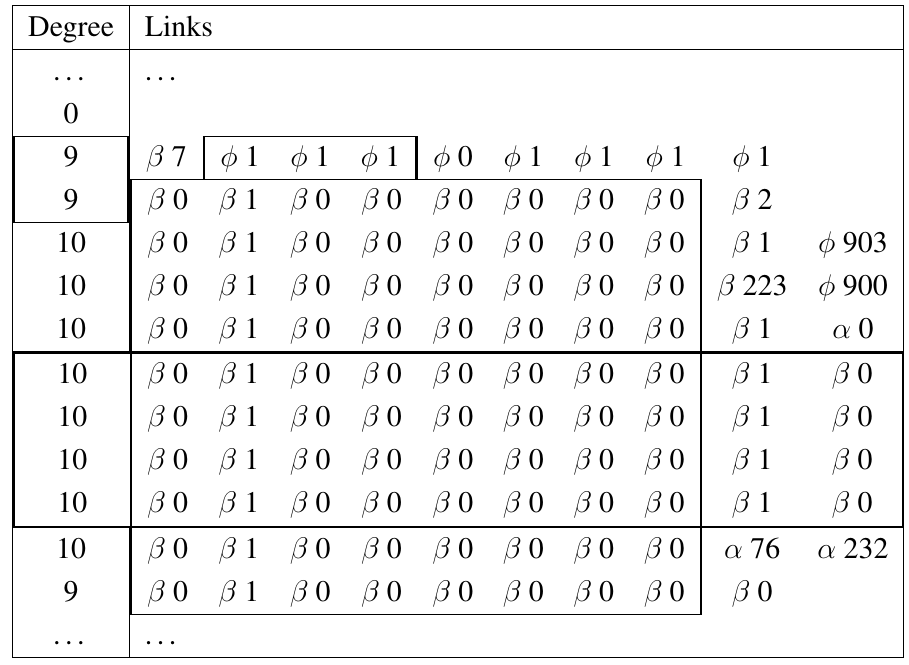
Table 4. Exploiting redundancies in adjacency